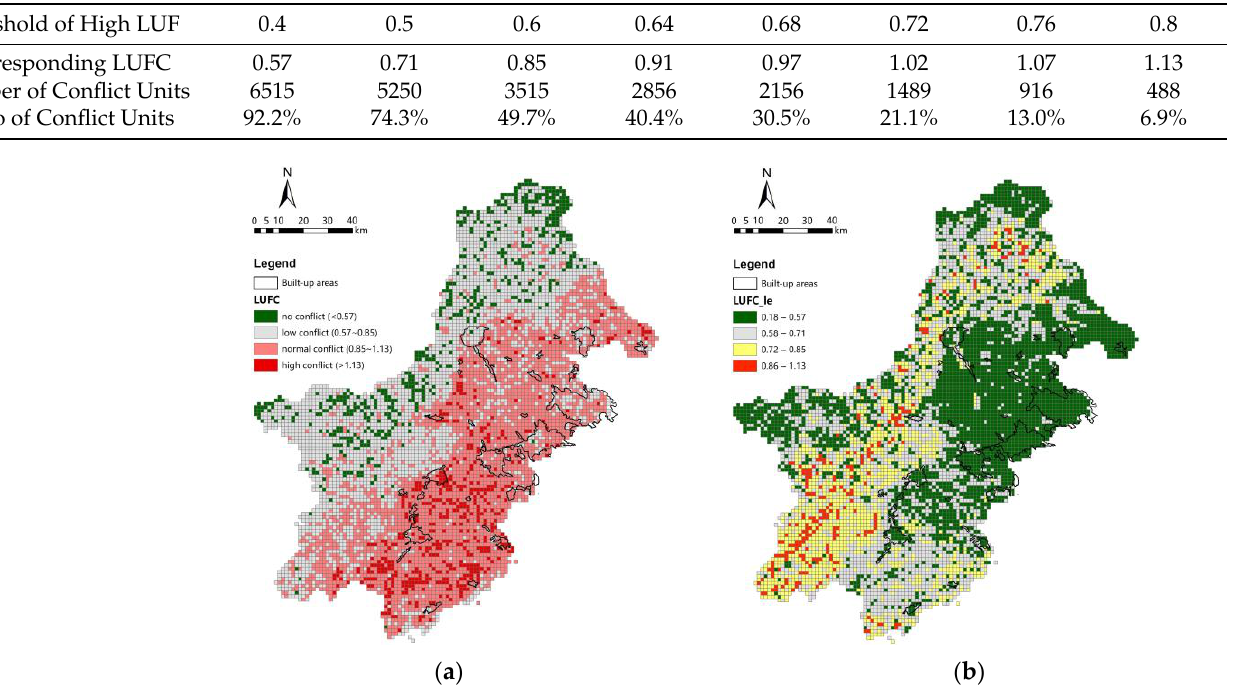
Table 3. Land-use status of conflict unit (km 2 ).